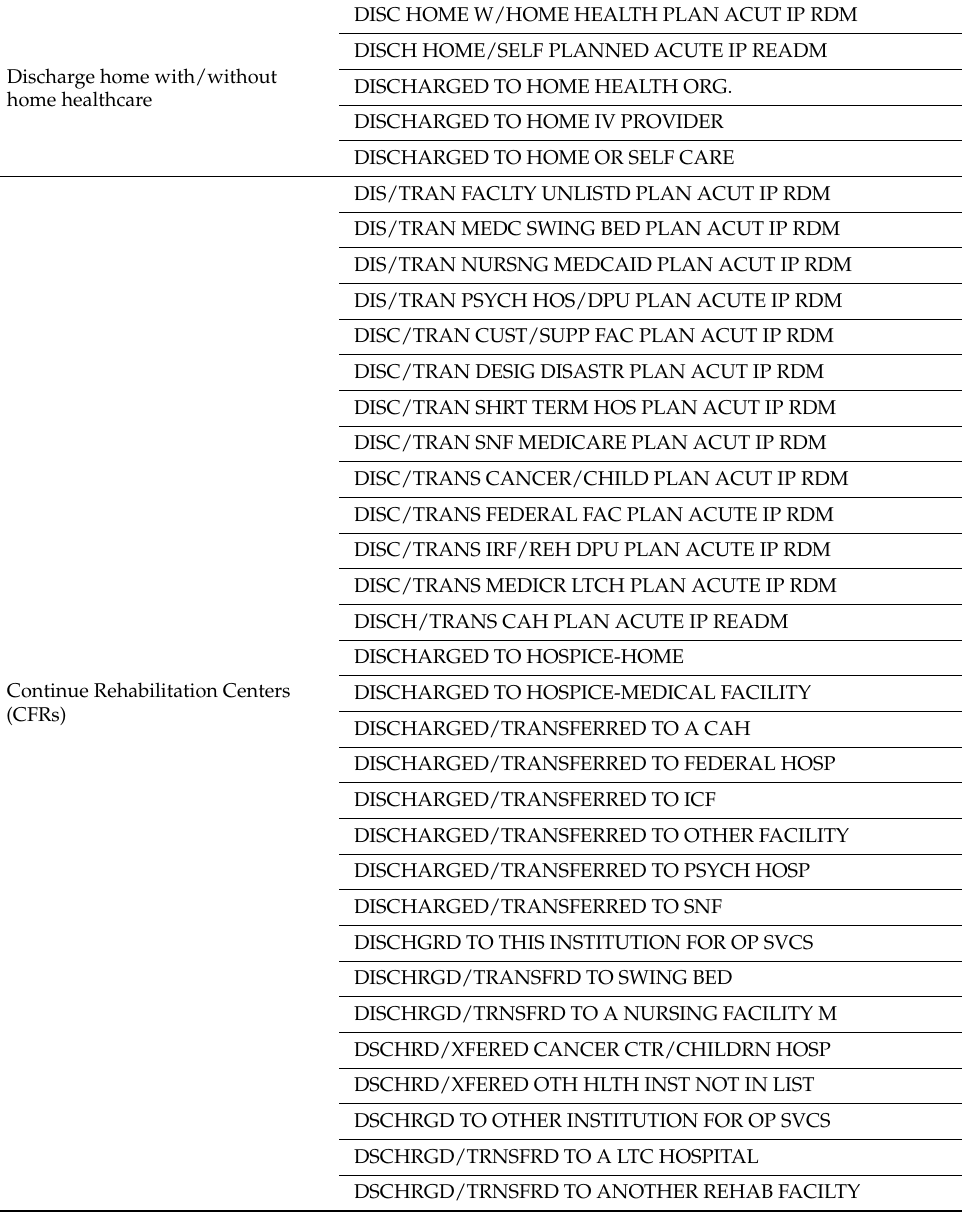
Table A1. Discharge Disposition Definition accordingly to Premiere Healthcare